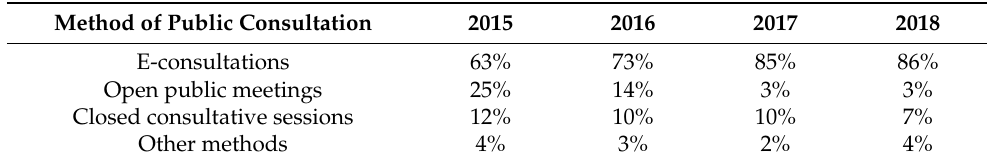
Table 2. Trends in use of e-consultations by Croatian government bodies, compared to other public consultation methods